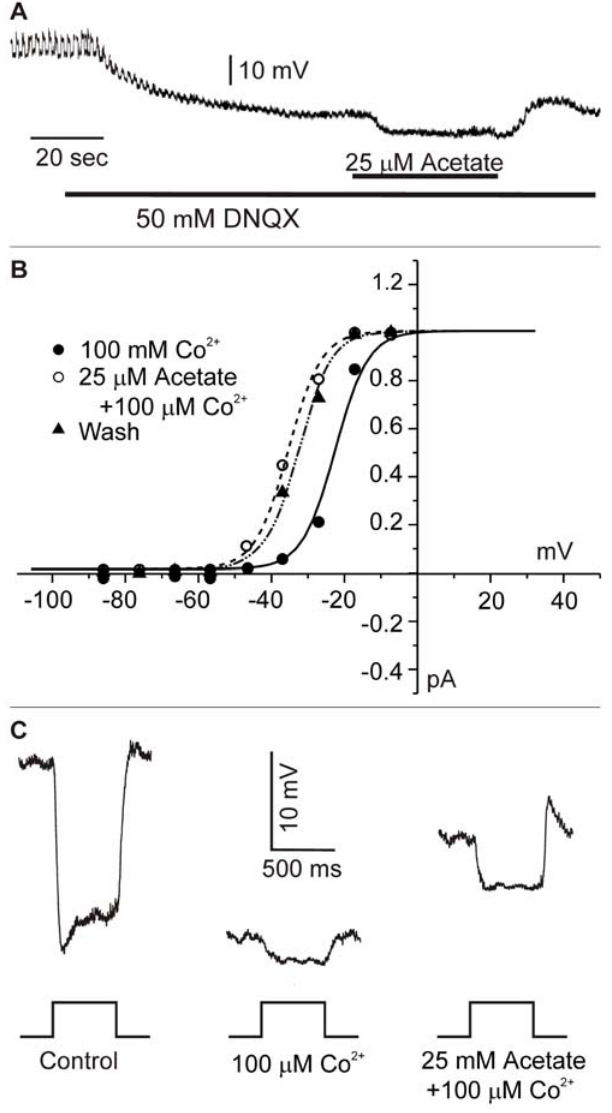
Figure 10. Effects of acetate on horizontal cells and cones in the isolated goldfish retina after chemical isolation. A , A horizontal cell was stimulated with full field 500 ms flashes of 500 nm light. Two time scales are given: one for the light flashes (top) and one for the whole trace (bottom). Removing synaptic input to a monophasic horizontal cell with 50 m M DNQX causes the cell to hyperpolarize. A subsequent application of acetate leads to a further hyperpolarization. B , Acetate exerts a direct effect on the cone Ca 2 + -current after pharmacologically isolating the cone from H-cell input with 100 m M Co 2 + . Boltzmann fits through activation function of the Ca 2 + -current in the presence of Co 2 + (filled circles), after application of 25 mM acetate (open circles), and after washout (filled triangles). Boltzman fits were obtained as described in Fig. 3a . In the presence of Co 2 + , acetate shifts the Ca 2 + -current to more negative potentials. C , Responses of a monophasic horizontal cell to 550 nm light (I=0 log) in control solution (left), after application of 100 m M Co 2 + (middle), and after subsequent application of 25 mM acetate (right). The low concentration of Co 2 + hyperpolarizes the horizontal cell and strongly reduces the amplitude of its light response. The addition of 25 mM acetate depolarized the cell, and increased the amplitude of the light response, indicative of an acetate-induced increase in neurotransmitter release.